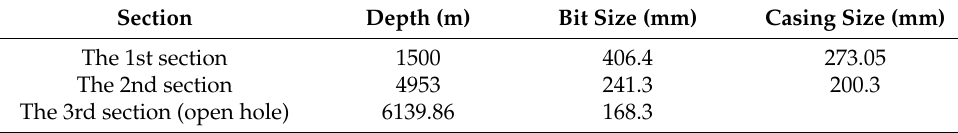
Table 3. Casing programs of well L.